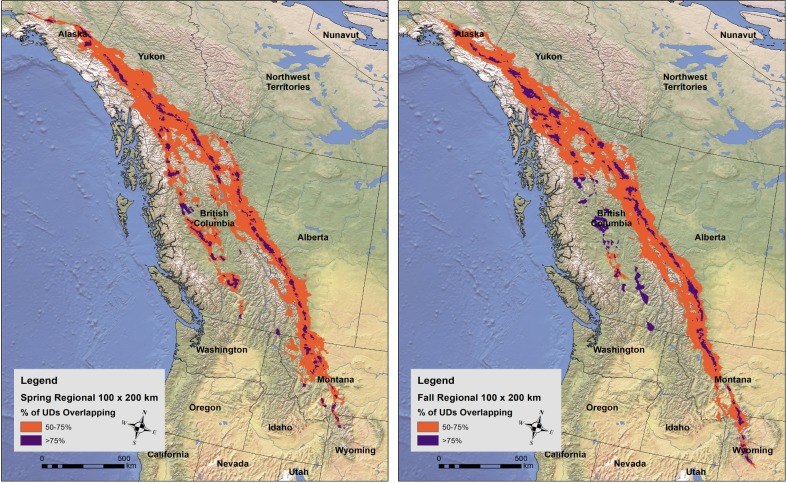
Final estimations of regional moderate- and high-use Golden Eagle spring (left) and fall (right) migration corridors in western North America using the proportion of eagles using a particular 2.5 km2 cell within a 100 x 200 km moving window.Moderate- and high-use corridors were determined by 50–75% and >75% eagle overlap within the moving window, respectively.